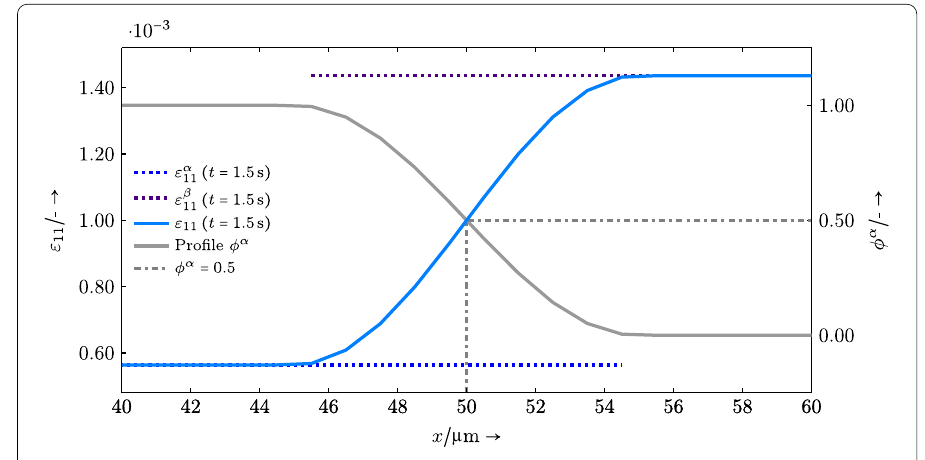
Fig. 7 Phase-inherent quantities in the interface region: Development of ε α averaged quantity ε 11 over x with y = 49 . 5 µ